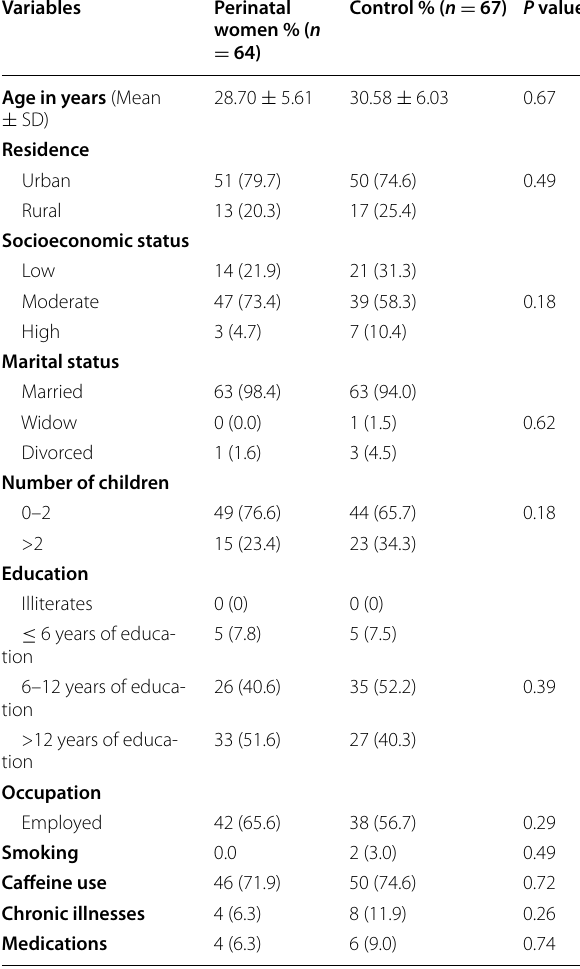
Table 1 Sociodemographic and clinical characteristics of the studied